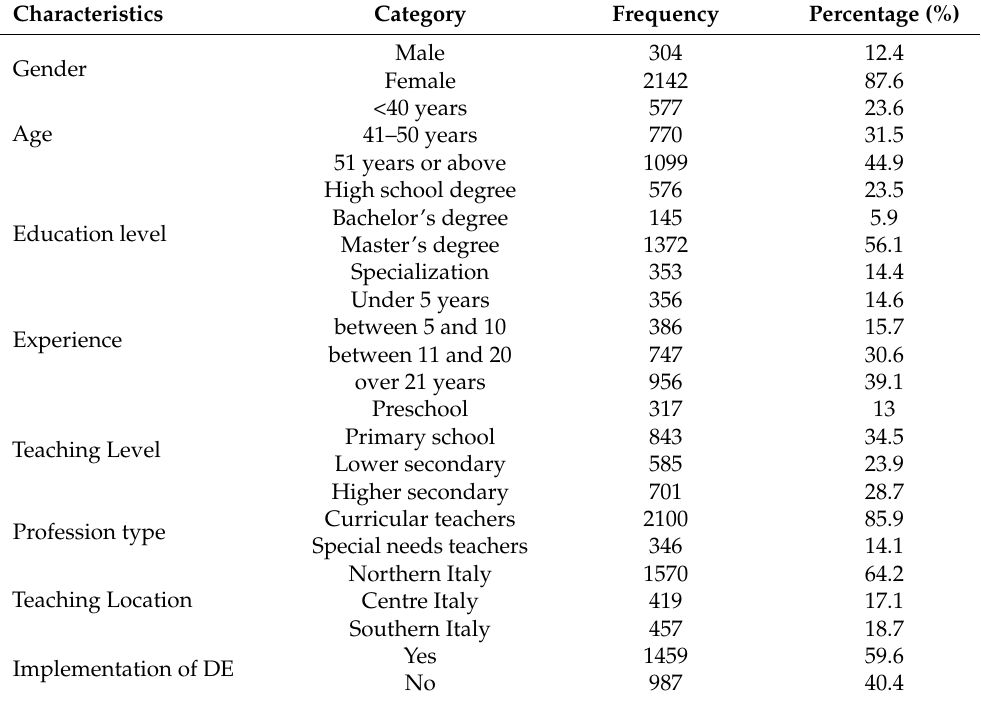
Table 1. Respondent